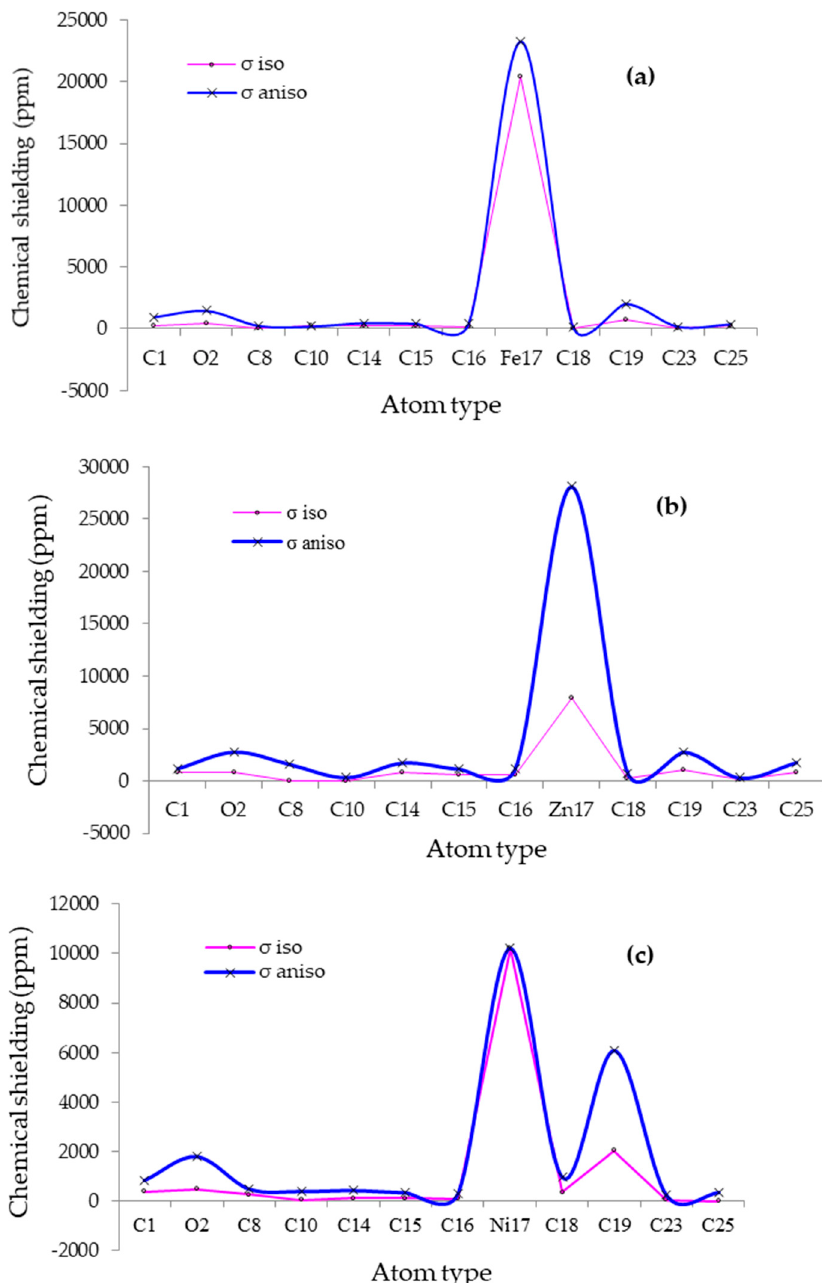
Figure 1. NMR spectroscopy for the adsorption of CO on the ( a ) Fe-doped/Gr, ( b ) Ni-doped/Gr, and ( c ) Zn-doped/Gr nanosheets.